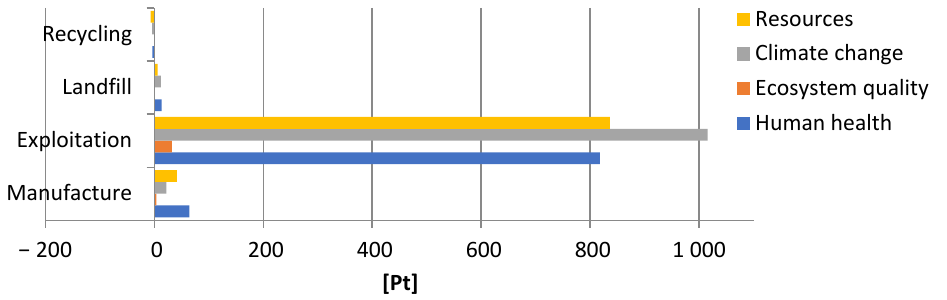
Figure 17. The results of grouping and weighing the environmental consequences occurring at individual stages of the life cycle of the research object by areas of influence.